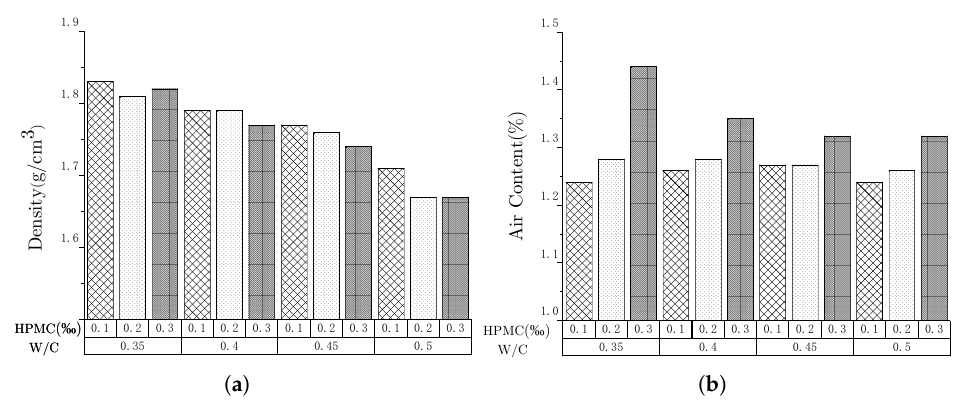
Figure 2. Different w/c ratios and HPMC dosages expressed in densities and air contents of fresh mortar. ( a ) Densities of fresh cement mortars; ( b ) air contents of fresh cement mortars.